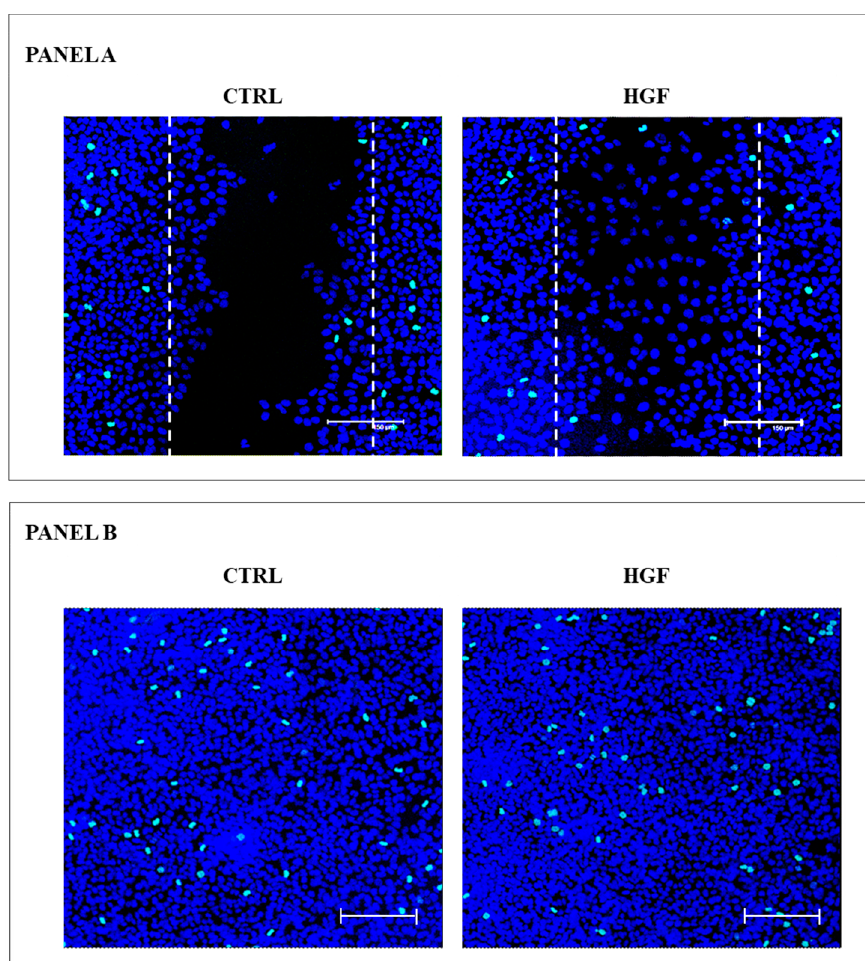
Figure 4. pHH3+ immunofluorescence in wound-healing assay. Panel A : Maximum projection of representative optical spatial series with step size of 1 µm recovered in the area of the wound. The images show NT2D1 cells, cultured for 48 h with or without HGF. Phospho-Histone H3 positive cells were immuno-labelled in green (FITC signal), whereas cell nuclei were stained with TOPRO-3 and appear blue (scale bar: 150 µm). The dotted lines indicate the presumptive area of the wound (that is 263,486 µm 2 ), calculated at the beginning of the wound-healing assay. Each whole photographic-field measures 562,500 µm 2 . All experiments were performed in triplicate. Panel B . Maximum projection of representative optical spatial series of the same samples of Panel A recovered in areas far from the wound in which cells appear over-confluent. Each photographic-field measures 562,500 µm 2 . Phospho-Histone H3 positive cells were immuno-labelled in green (FITC signal), whereas cell nuclei were stained with TOPRO-3 and appear blue (scale bar: 150 µm).